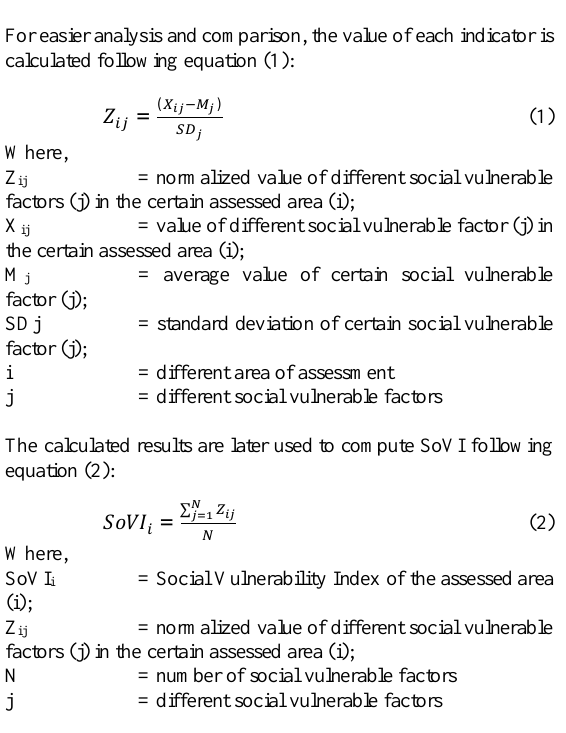
Table 2. The indicators and variables of social vulnerability (Frigerio, I., et al,